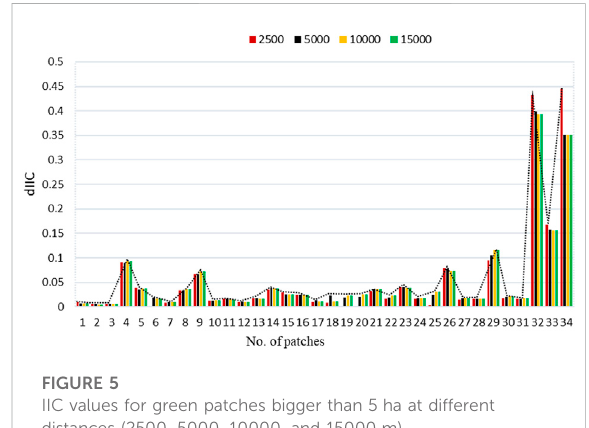
FIGURE 5 IIC values for green patches bigger than 5 ha at different distances (2500, 5000, 10000, and 15000 m).